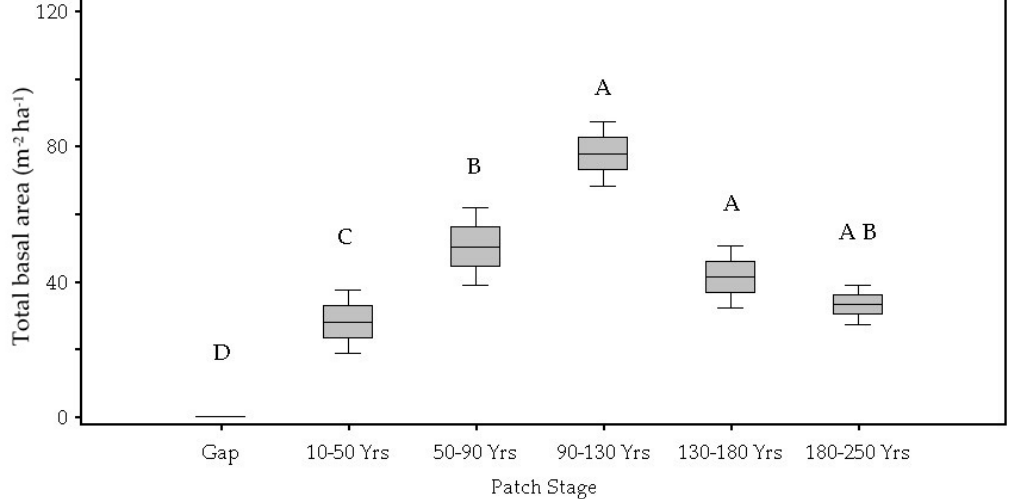
Figure 2. Total basal area in patch stages. Total basal area (m − 2 ha − 1 ) of Pinus palustris for plots in each patch stage ( n = 10). Boxes represent plot distribution within one standard deviation of the mean (box centerline). Error bars indicate standard error and shared letters indicate non-significant differences between patch stages.